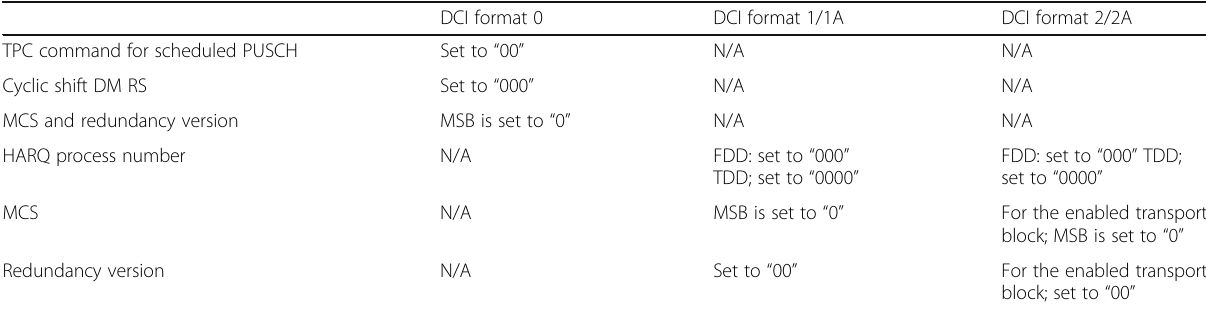
Table 2 Special fields for SPS activation PDCCH validation